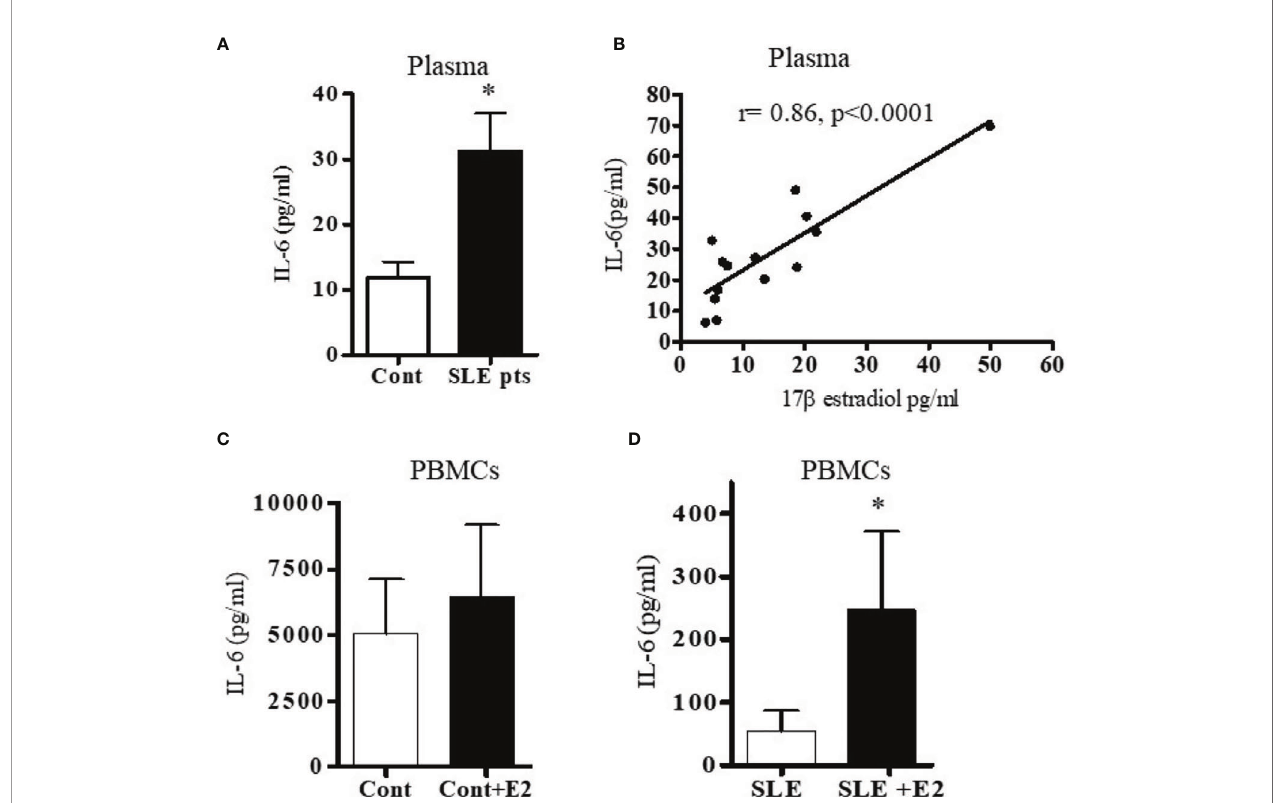
FIGURE 2 | SLE patients have increased levels of the pro-in fl ammatory cytokine IL-6. Plasma estradiol positively correlates with IL-6. 17 b -estradiol increased IL-6 levels in both healthy control and in SLE patients ’ PBMCs. (A) Plasma levels of IL-6 were measured in female SLE patients (n=13) and in healthy controls (n=11) by ELISA. (B) Correlation between plasma 17 b -estradiol levels and IL-6 in SLE patients (n=14), (p < 0.0001). PBMCs of healthy controls, n=11 (C) and SLE patients, n=11 (D) were cultured with 17 b -estradiol (50 pg/ml) for 24-48 h and supernatants measured by multiplex assays. *p <